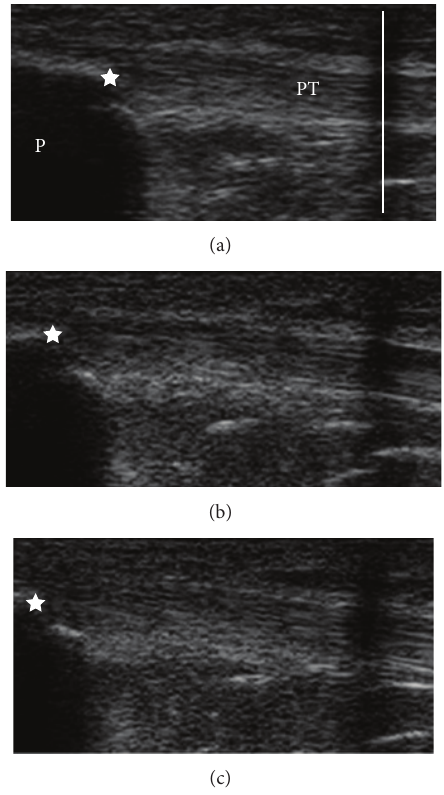
Figure 1: Illustration of patellar (P) tendon (PT) elongation. PT elongation shown from a skin marker (vertical line) to the tendon insertion at the patella (star) using US at rest (a) and during contractions ((b) and